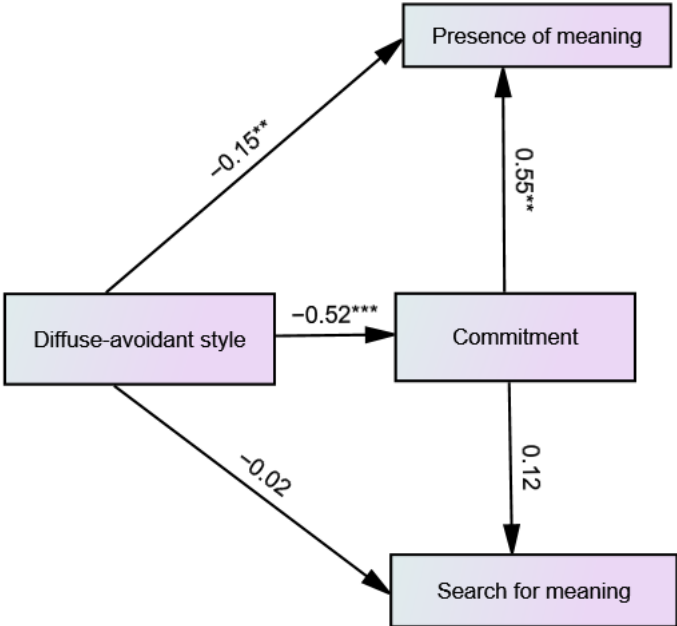
Figure 3. Path diagram of the predictive relationships between diffuse-avoidant identity style, com- mitment, presence of meaning and search for meaning including the standardized path coefficients. ** p < 0.01. *** p < 0.001.